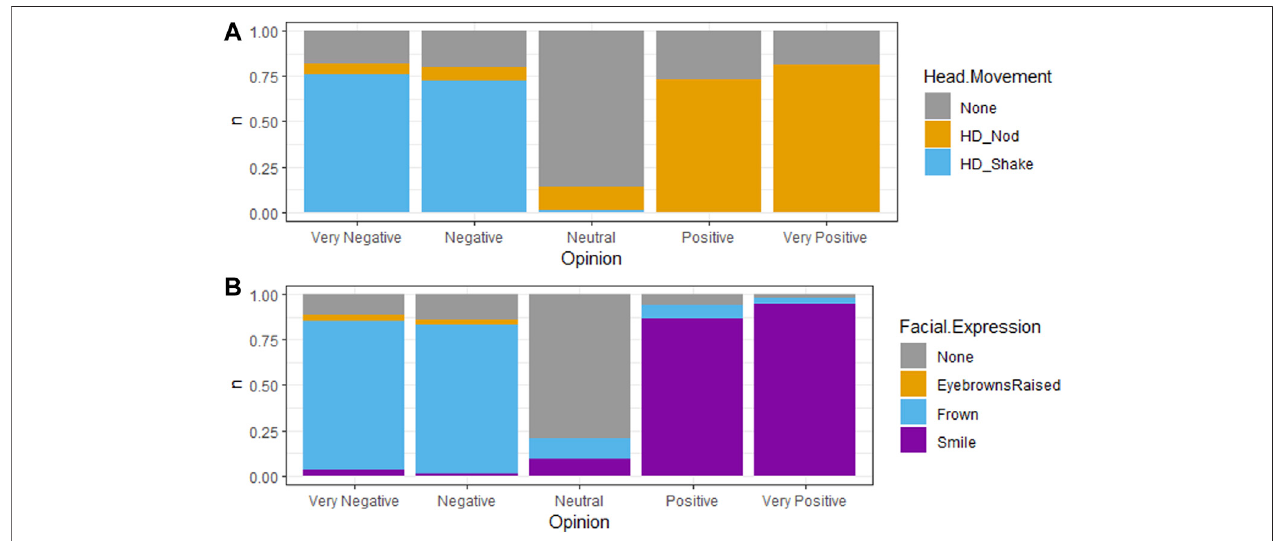
FIGURE 6 | Distribution of behaviors per state levels for the investigated hypotheses. The fi ve bars in each sub- fi gure correspond to the fi ve possible values of valence, very negative, negative, neutral, positive and very positive. (A) is related to the head movements types and (B) to the facial expressions types.